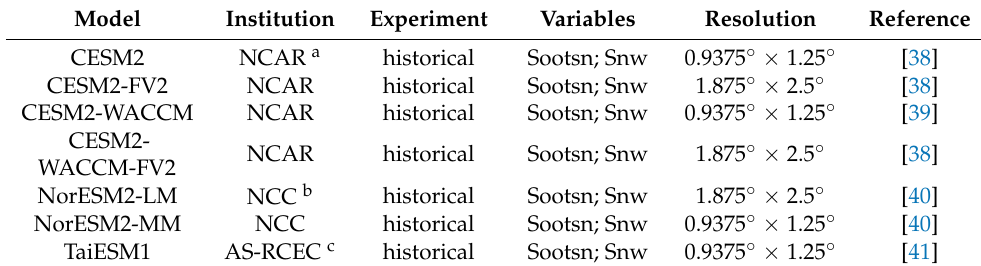
Figure 1. Global BC emission rates averaged over 1980–2014, and regional groupings. Table 1. Model outputs used in this